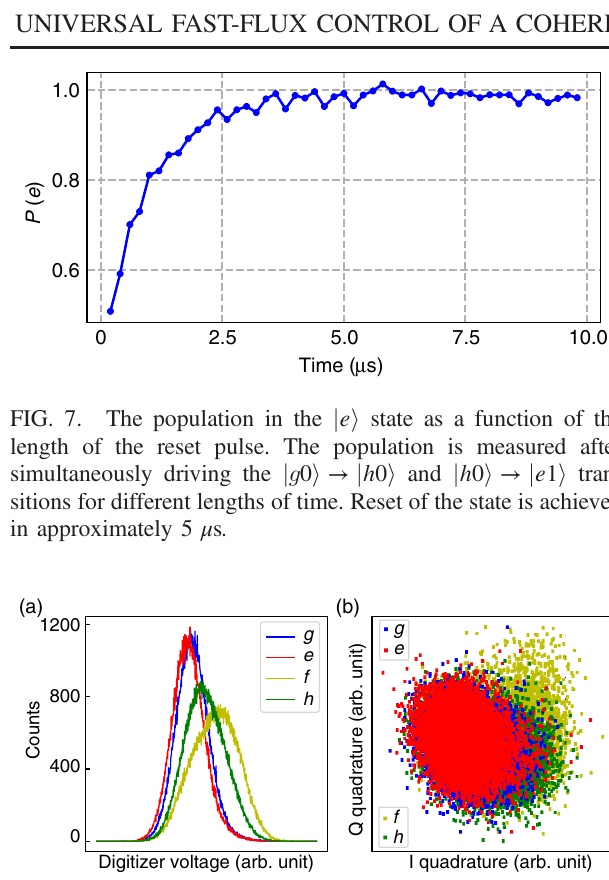
FIG. 8. Readout histogram and single-shot data (a) histogram of the lowest four fluxonium states ( j g i , j e i , j f i , and j h i ). The j g i − j f i readout fidelity is approximately 50%. (b) The distri- bution of all single-shot data from the lowest four fluxonium states on the IQ (IQ are defined from the two IF channels of the I/ Q mixers. I for the in-phase component and Q for the 90° out-of- phase component)